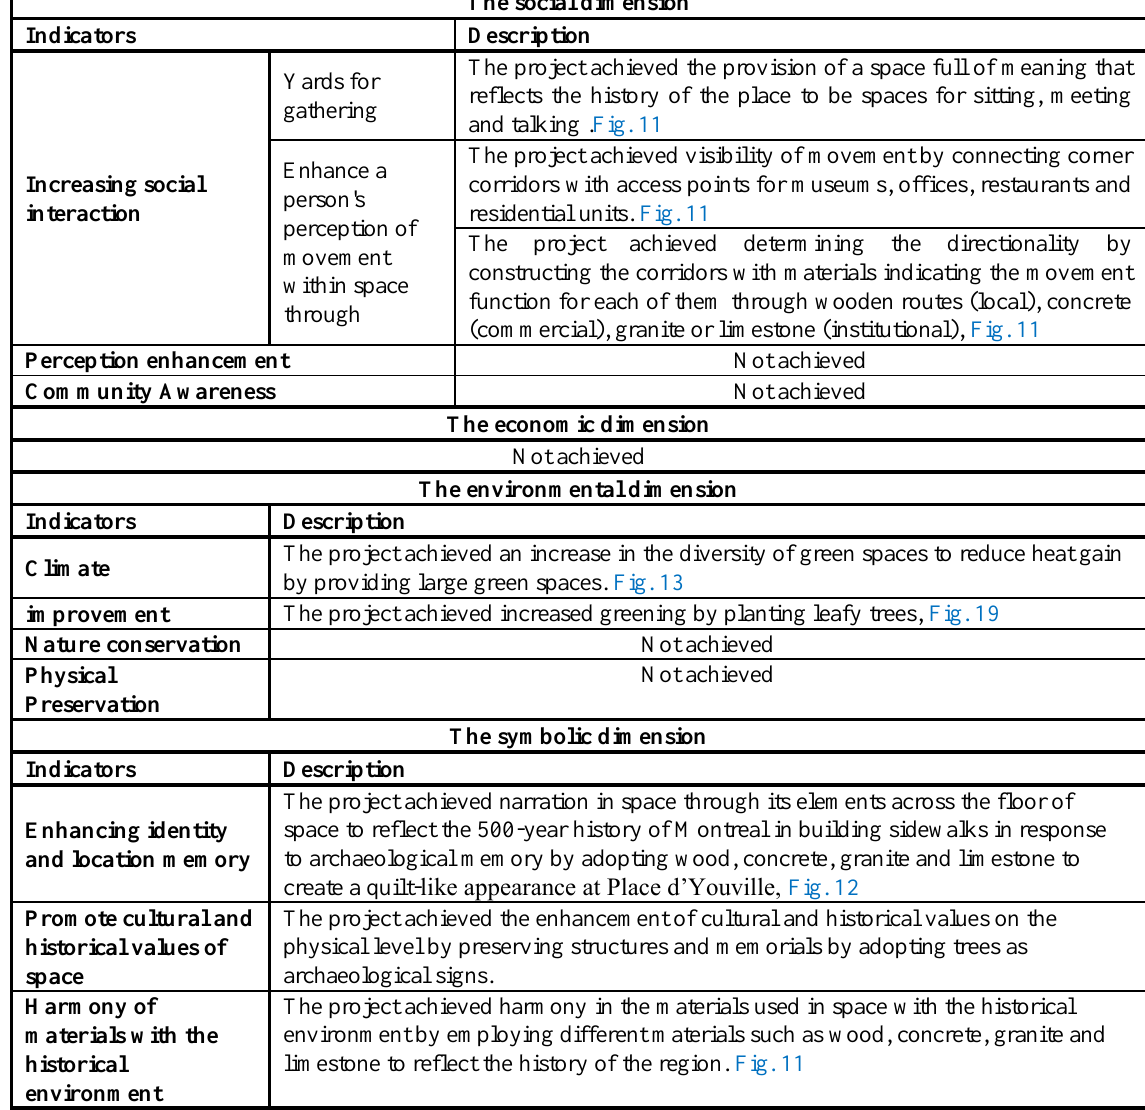
Table 4. The form of measuring verification values for the dimensions of activating landscapes third case, (prepared by the researchers). The social dimension Description Indicators The project achieved the provision of a space full of meaning that reflects the history of the place to be spaces for sitting, meeting and talking .Fig.